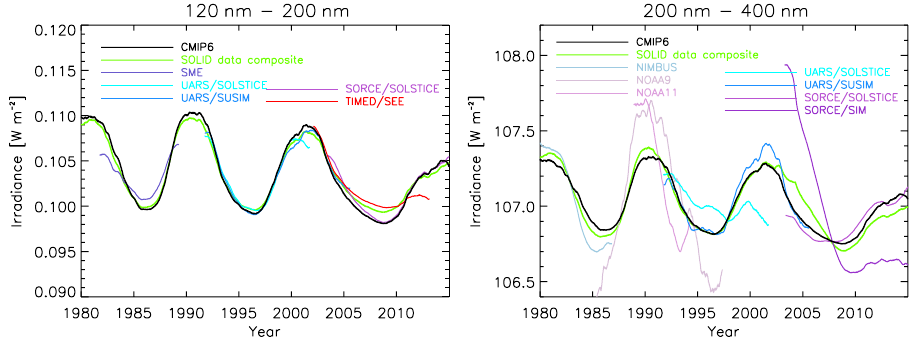
Figure 3. CMIP6-recommended SSI time series (black) from 1980 to 2015 together with the SOLID.beta data composite (green) and relevant instrument observations for the following wavelength bins: 120–200nm (left) and 200–400nm (right). The SOLID and instrument time series have been adjusted to match the average level of the CMIP6 time series. Note that the longest wavelength observed by TIMED/SEE is 189nm, the longest observed wavelength by SORCE/SOLSTICE is 309nm and the shortest observed wavelength by SORCE/SIM is 240nm. All time series are running averages over 2 years.